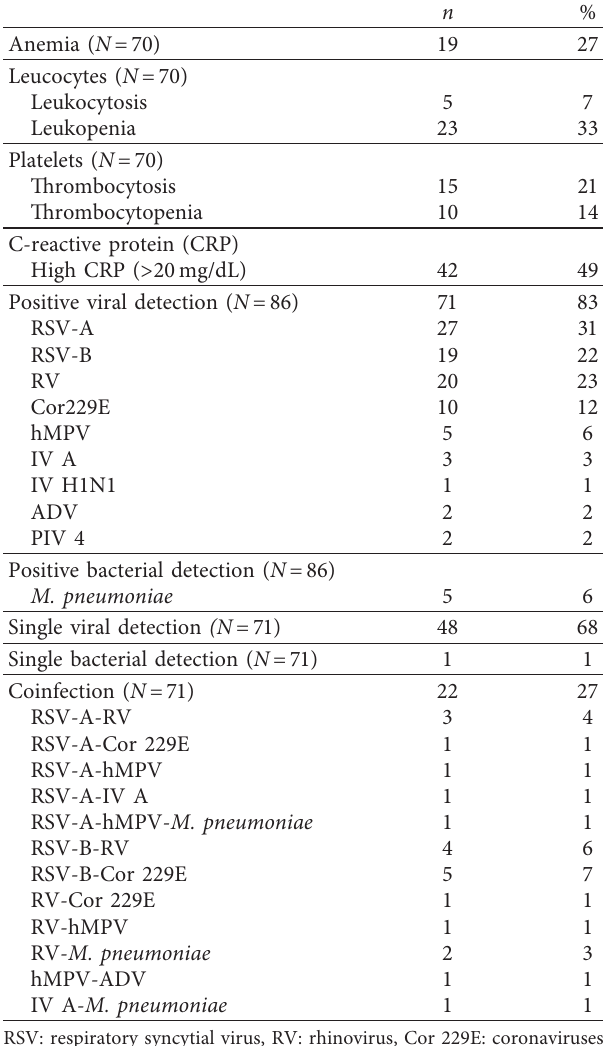
Table 4: Biological results of hospitalized patients (December 1, 2016, to May 31, 2018).